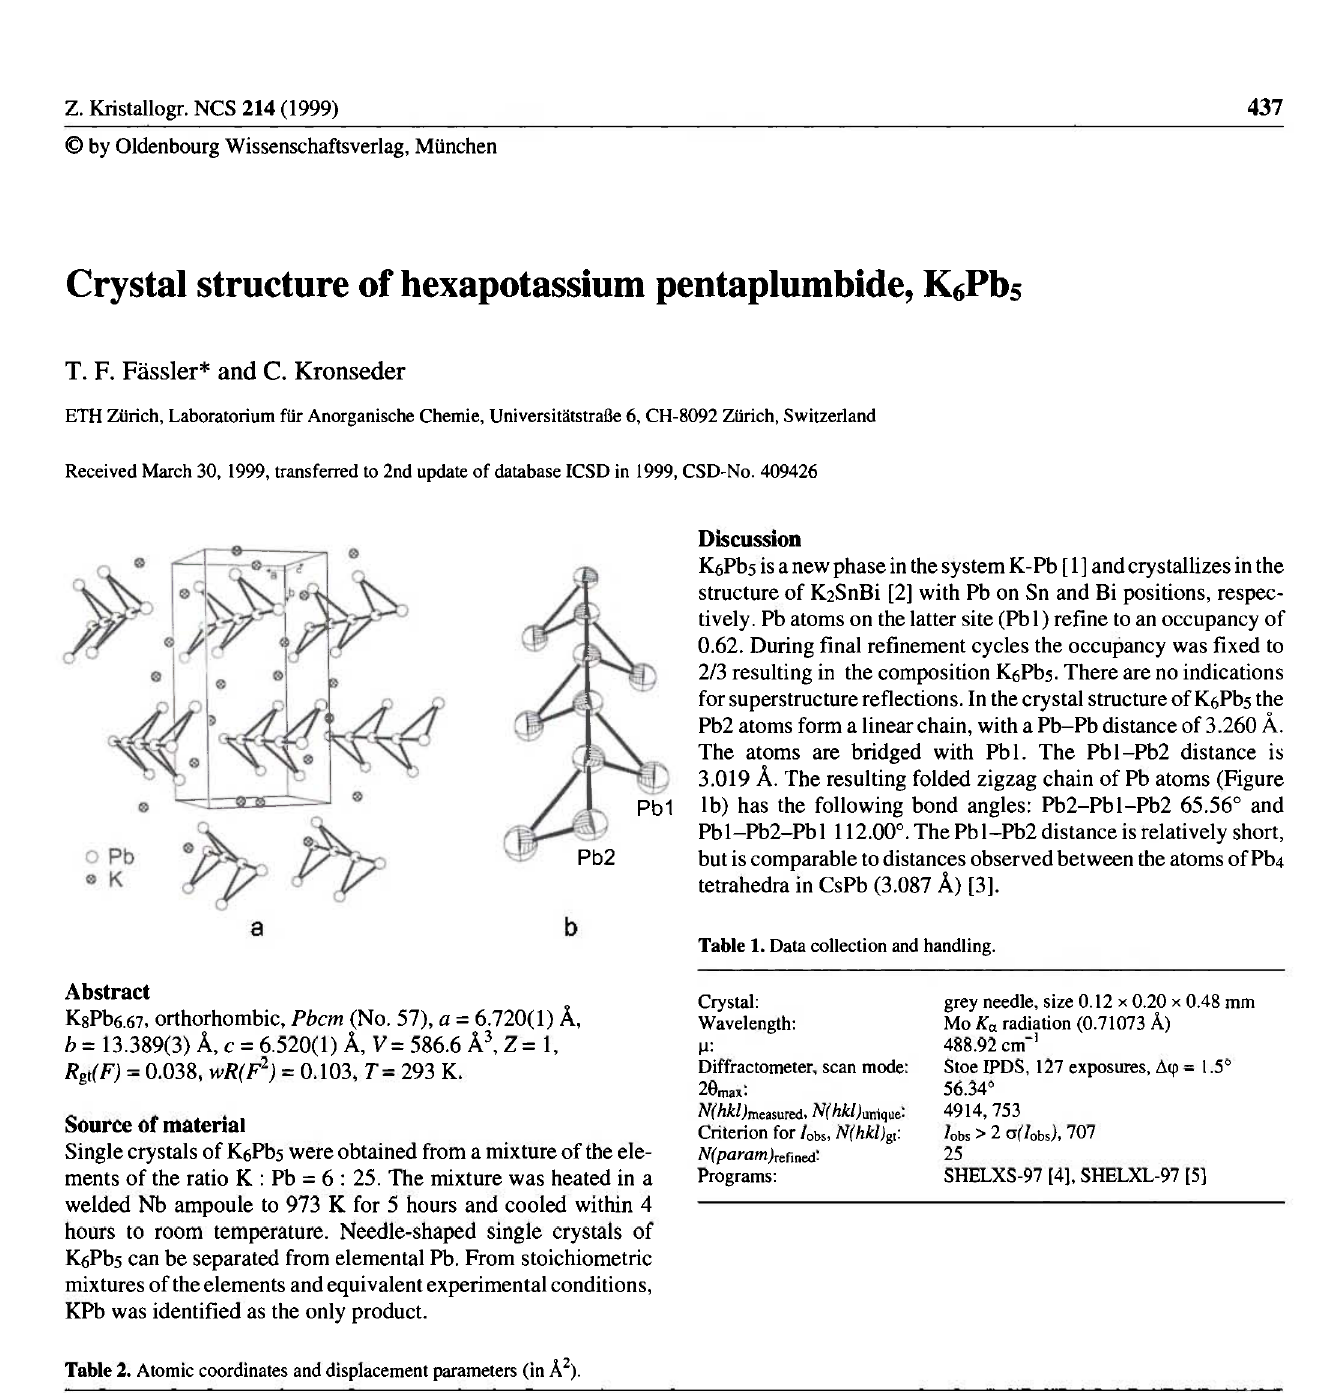
Table 2. Atomic coordinates and displacement parameters (in Ä 2 ).